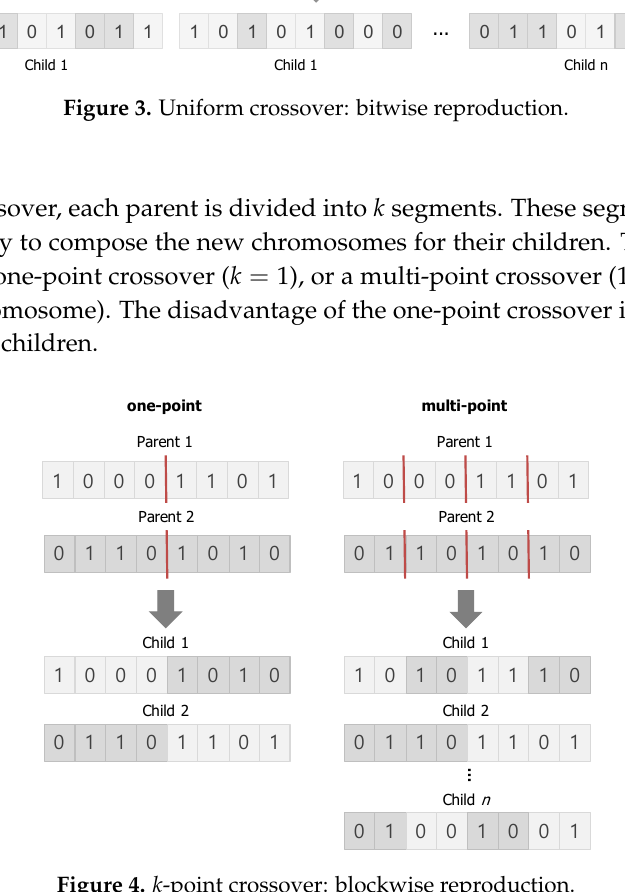
Figure 5. Mutation of a bit in a